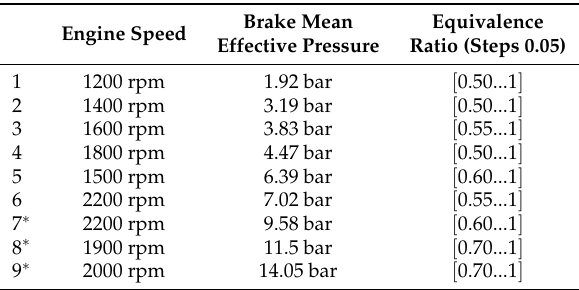
Table A3. Overview operating points.